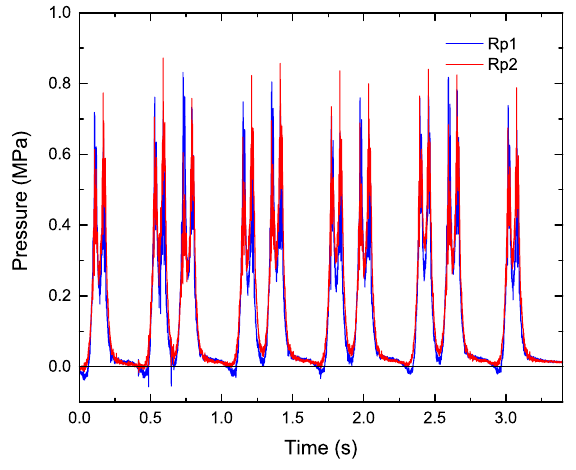
Figure 5. Time history of pressure between sleeper and rail at positions of the right rail (Rp1) and the left rail (Rp2). In these data, the number of passing cars was five, where one car had two bogies, and each bogie had two axles.